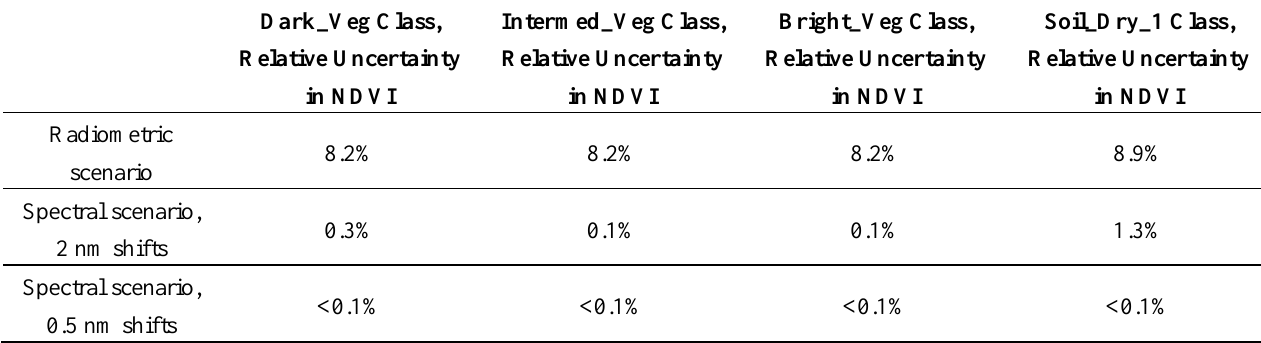
Table 4. Relative uncertainty of the NDVI for selected ROIs.